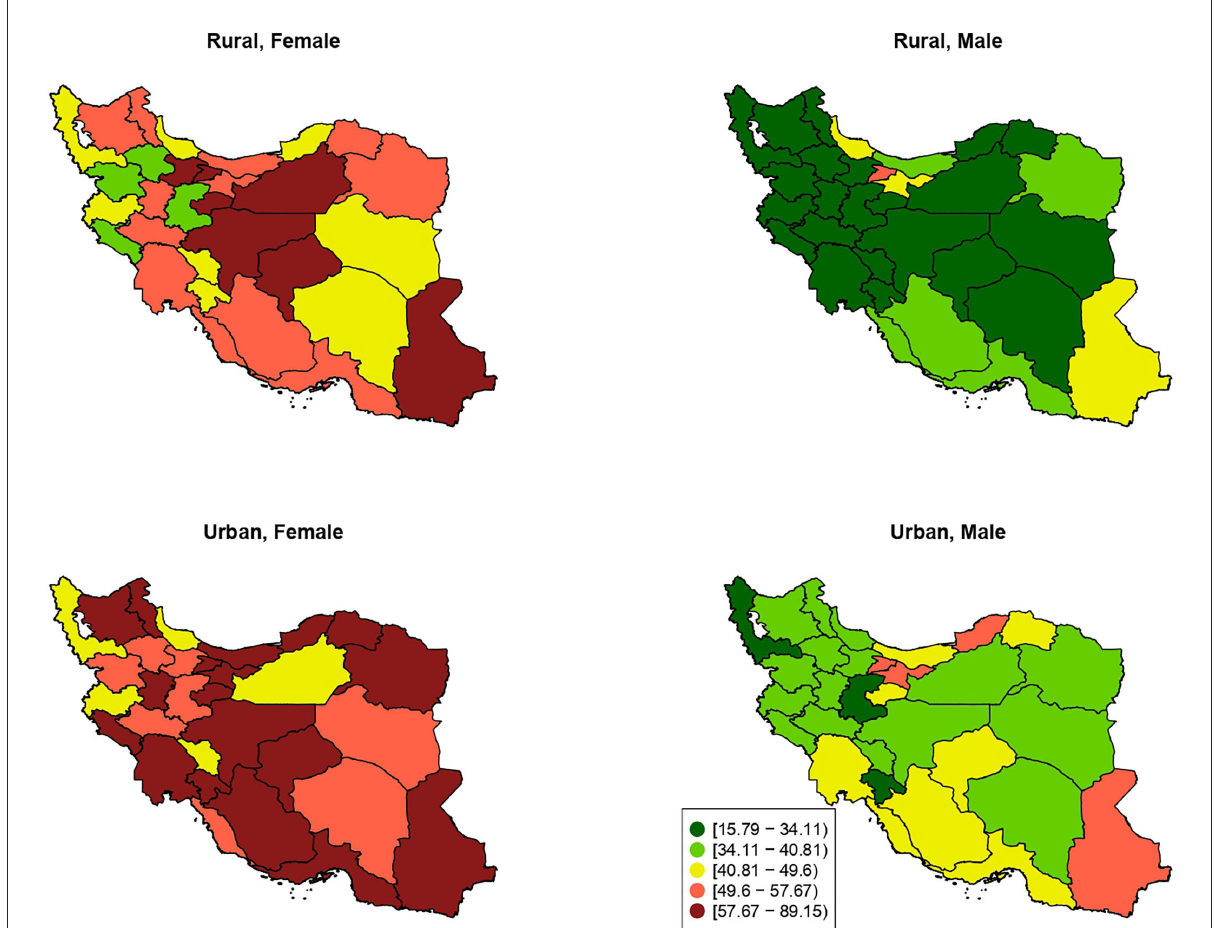
FIGURE2 The provincial distribution of age-standardized prevalence of insufficient physical activity (percentage %) by residential area and sex.